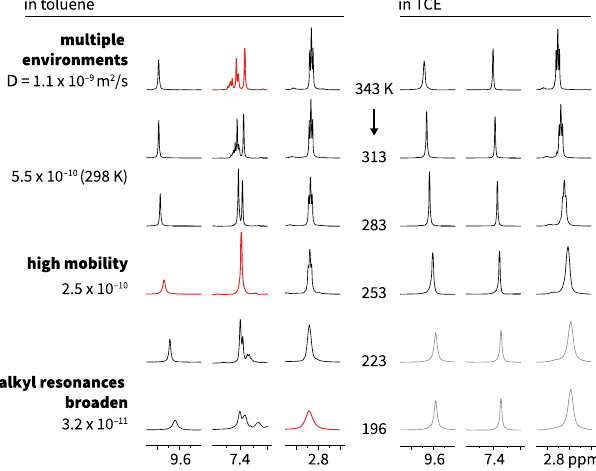
Fig. 2 Variable temperature 1 H NMR of 2H-Car-C6 in toluene- d 8 and TCE- d 2 . Selected regions and temperatures only, see Supplementary Information for the entire datasets. In TCE broadening is only observed at low temperatures while in the aggregation-inducing solvent (toluene) distinct environments emerge at low and high temperatures. Gray signals in TCE are measured at 233